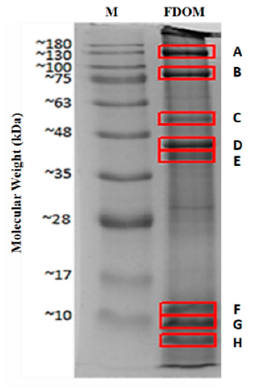
Figure 1. Protein patterns of Portuguese Oyster ( C. angulata ) by 12% sodium dodecyl sulphate polyacrylamide gel electrophoresis (SDS-PAGE). M: Protein marker; FDOM: freeze-dried oyster ( C. angulata ) meat.